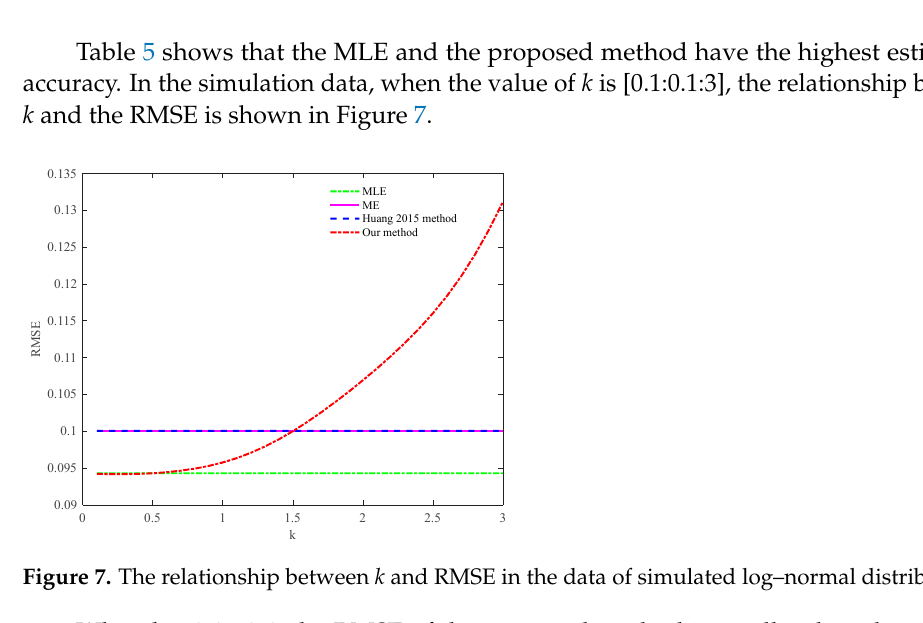
Table 5. The statistics of estimation accuracy in simulated log–normal distribution ( k = 0.5). Estimation Method